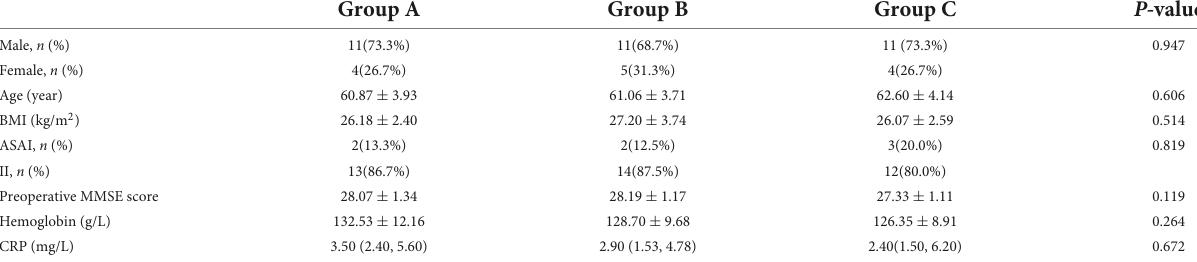
TABLE 1 Demographic and preoperative characteristics.